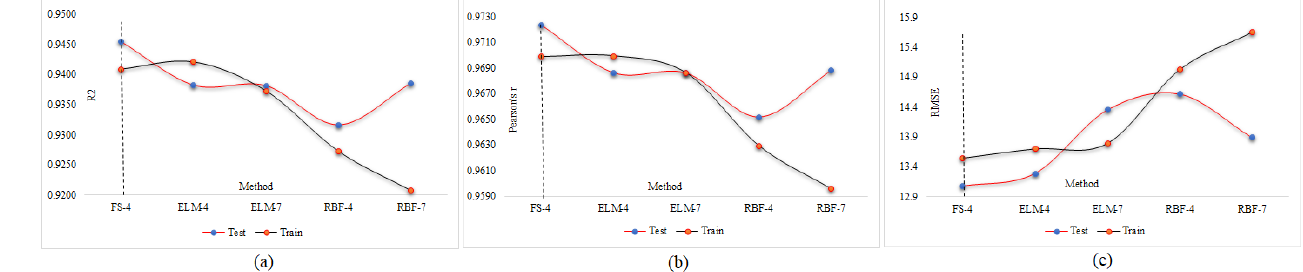
Figure 29. Comparing performance parameters for different methods: ( a ) R 2 , ( b ) r , and ( c ) RMSE